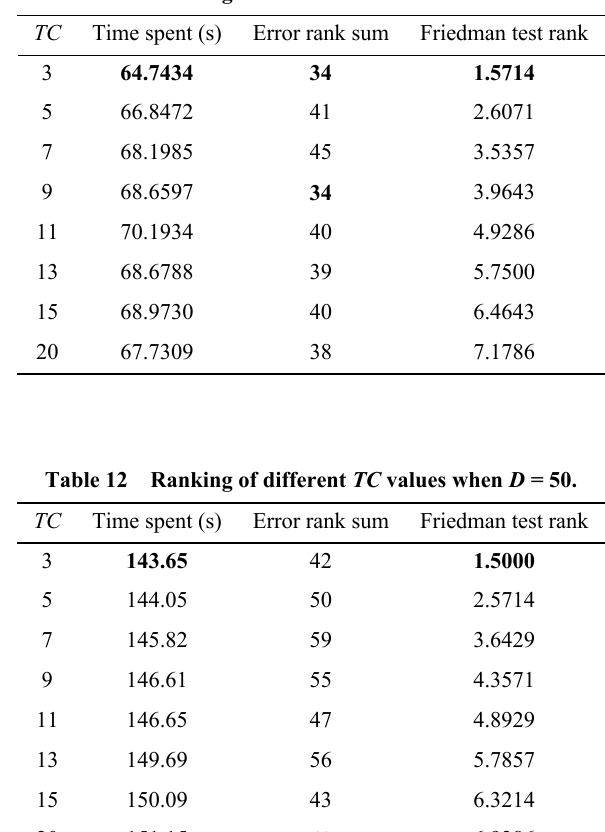
Table 11 Ranking of different TC values when D = 30.